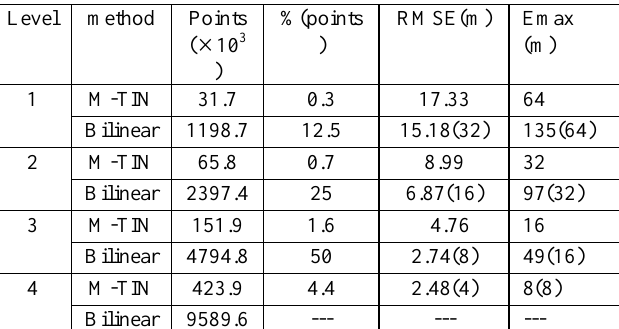
Table 1. A comparison between bilinear method and M-TIN